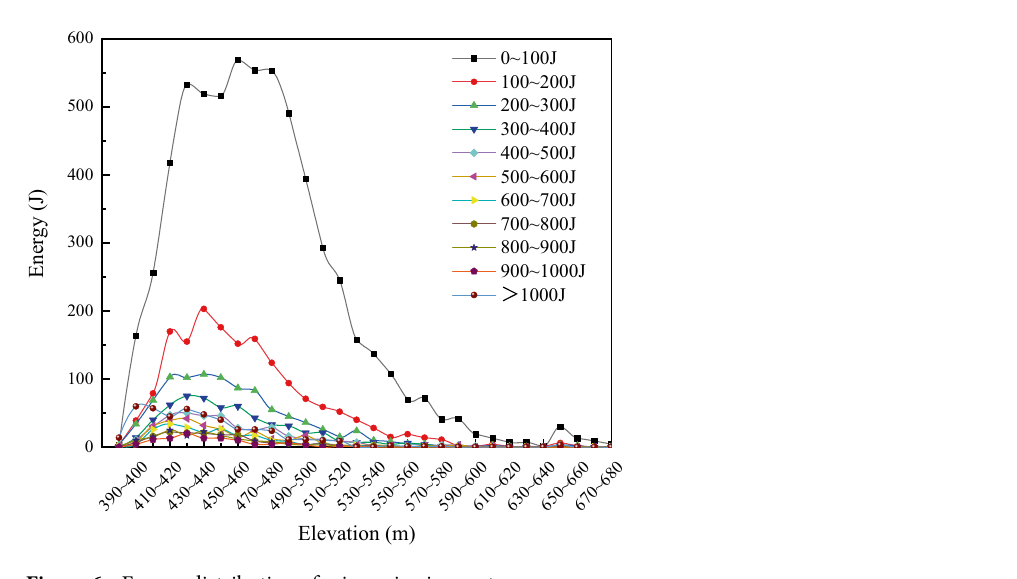
Figure 6. Energy distribution of microseismic